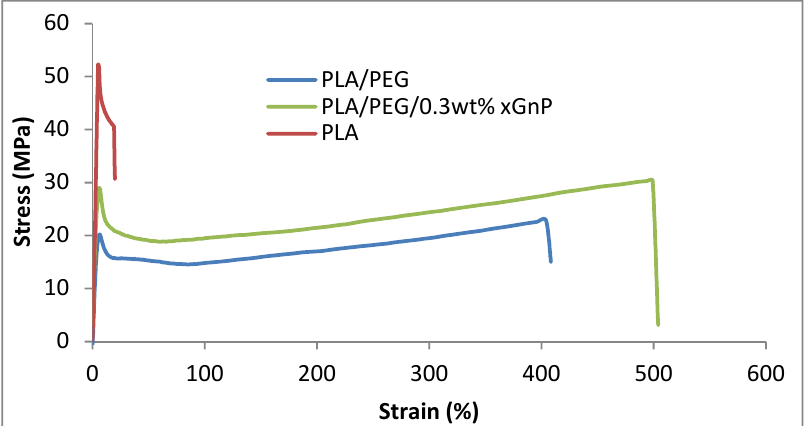
Figure 4. Stress-strain curves of PLA, PLA/PEG, and PLA/PEG/xGnP